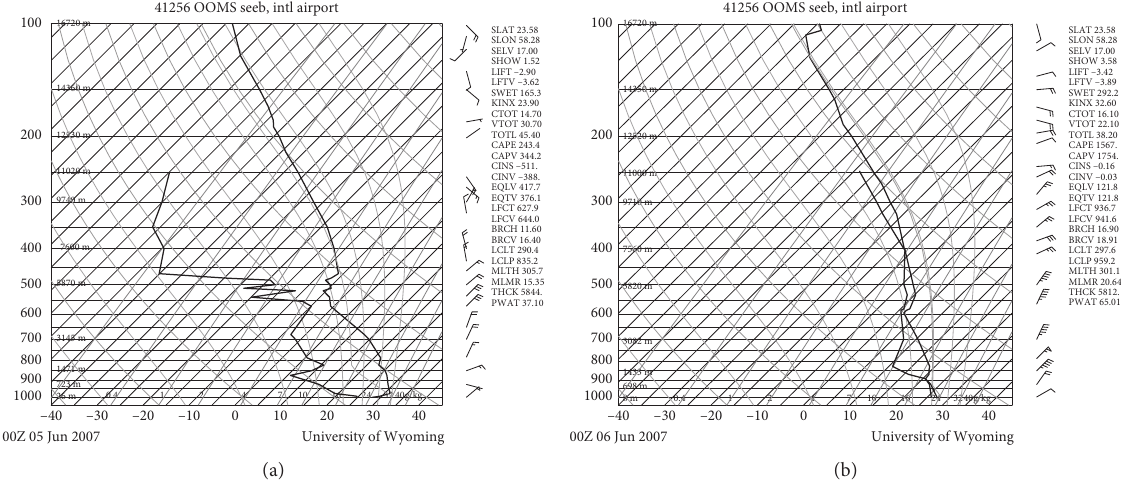
Figure 3: The upper air sounding on (a) 5th of June 2007 (b) 6th of June 2007 (source: University of Wyoming, 2007). The vertical distribution of wind is indicated by wind barbs on the right of the